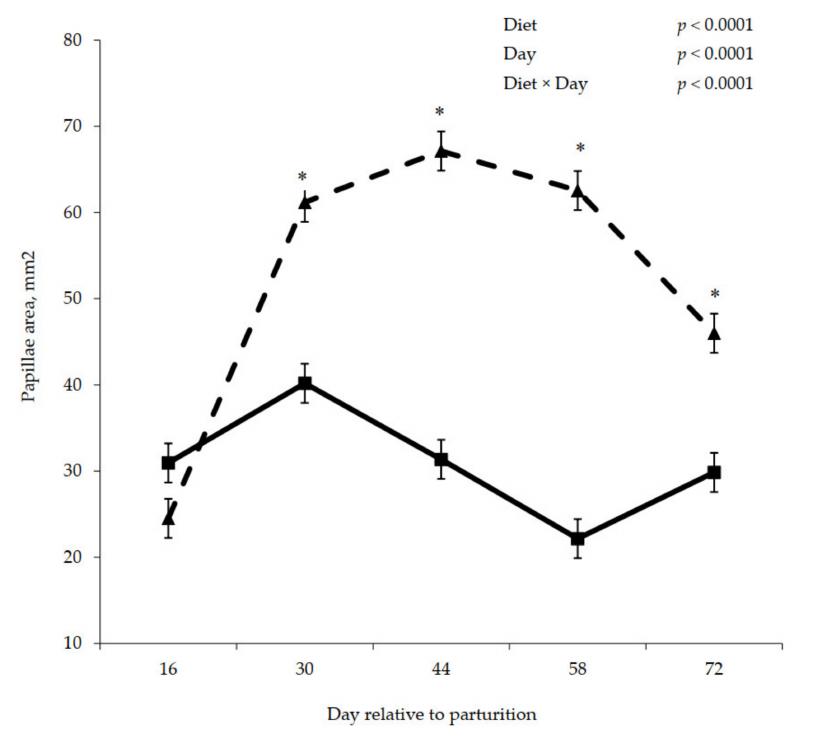
Figure 7. Postpartum rumen papillae surface area for cows fed control (triangles) or molasses- containing (squares) diets during a 60 day dry period (error bars = pooled standard error of the mean, Experiment 2, n = 3). * Within each day, means differ at p ≤